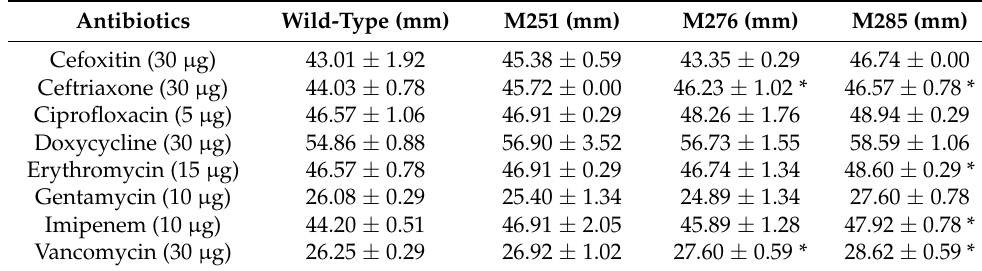
Figure 5. Antibacterial activity of the wild-type and its mutants (SPR19) after 15 consecutive genera- tions. The CFS of the wild-type and mutants were used to measure the antibacterial activity against ( a ) S. aureus TISTR 517, ( b ) MRSA isolate 142, ( c ) MRSA isolate 1096, and ( d ) MRSA isolate 2468. The experiments were performed in triplicate, and the results were expressed as mean ± SD ( n = 3). Table 2. Antibiotics susceptibility of Brevibacillus sp. SPR19 and its mutant strains (mean ± SD; n =